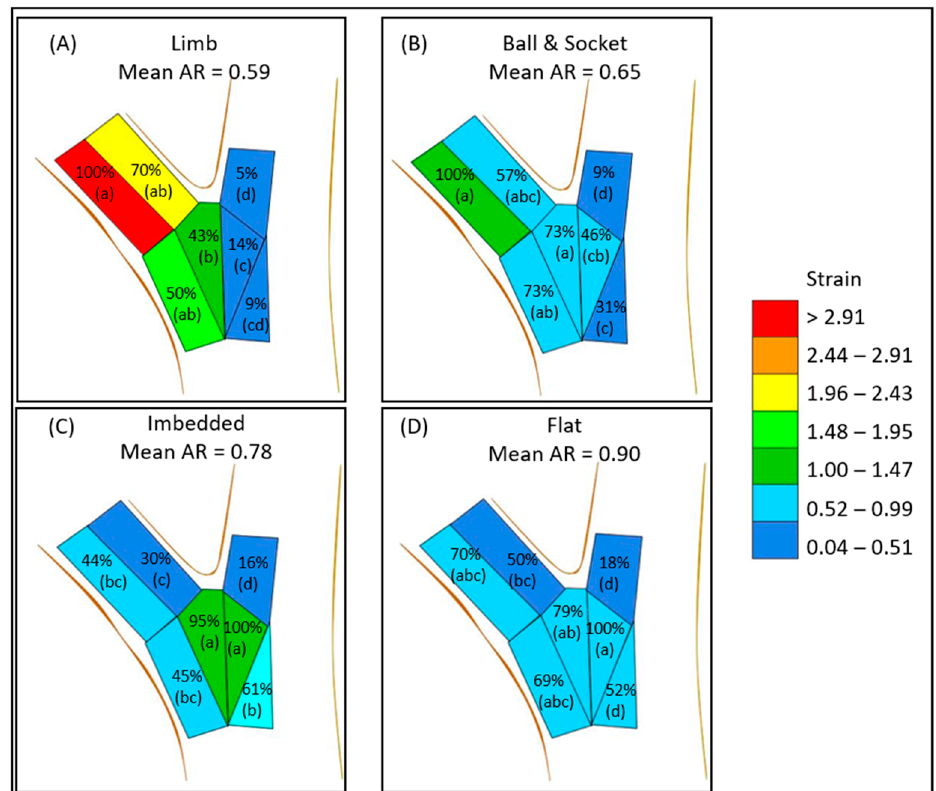
Figure 7. Mean max strain distribution and mean aspect ratio (AR) for each failure modes: limb ( A ), ball and socket ( B ), imbedded ( C ), and flat ( D ). Percentages indicate the percent of the mean maximum strain of all the zones for the given failure mode. ANOVA with HSD was conducted within each failure mode, and zones with different letters were found to be significantly different (see Table 3 for numerical analysis).